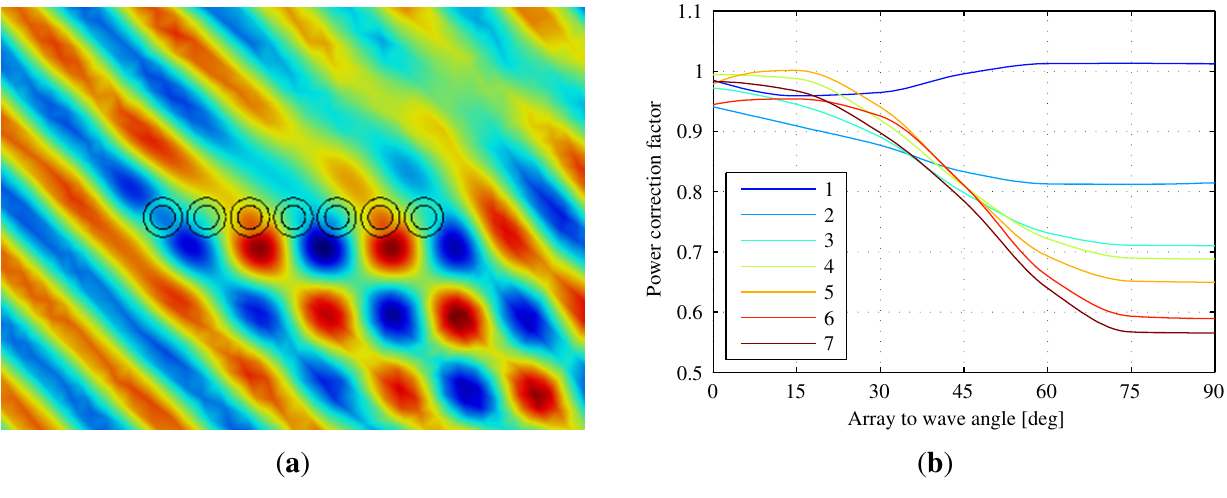
Figure 11. Hydrodynamical interference between absorbers. ( a ) Illustration of the wave interaction with the array. The wave direction is from southwest and thus causes amplification on the southern side of the array and attenuation on the northern side; ( b ) Power correction factors for absorbers in array calculated from shadowing effects ( T z = 6 . 5 s